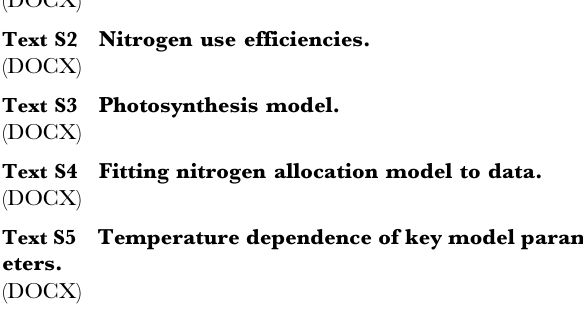
Text S6 V c,max and J max standardization. (DOCX) Figure S1 Sensitivity analysis of the relationship be- tween V c,max25 and leaf nitrogen to changes in proportion of respiratory nitrogen allocated to leaf ( f r ). f r increases from 0.4 to 0.6. The nitrogen storage duration is set to be 65 days. Other parameters are from test case 1 in Table 1. (TIF) Figure S2 Sensitivity analysis of the relationship be- tween V c,max25 and leaf nitrogen to changes in proportion of storage nitrogen allocated to leaf ( f s ). f s increases from 0.3 to 0.8. The nitrogen storage duration is set to be 65 days. Other parameters are from test case 1 in Table 1. (TIF) Figure S3 Sensitivity analysis of the relationship be- tween V c,max25 and leaf nitrogen to changes in nitrogen storage duration ( D ns ). D ns increases from 5 to 65. The proportion of storage nitrogen allocated to leaf ( f s ) is set to be 0.8. Other parameters are from test case 1 in Table 1. (TIF) Figure S4 CO 2 fertilization effects on leaf nitrogen allocation for test case one. In panel (a), closed and open circles represent observed V c,max scaled to 25 u C (i.e., V c,max25 )for loblolly pine ( Pinus taeda ) with ambient (370 ppm ) and elevated CO 2 concentration (570 ppm ), respectively. Solid lines are estimates of V c,max25 by the nitrogen allocation model tuned to ambient CO 2